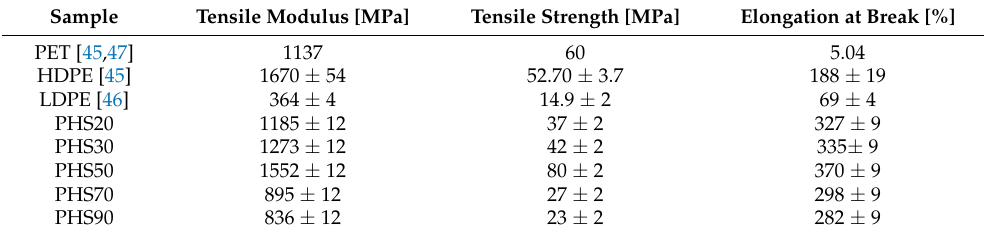
Table 5. Comparison of the tensile properties of copolyesters PHS(20–90) and commercial polymers.